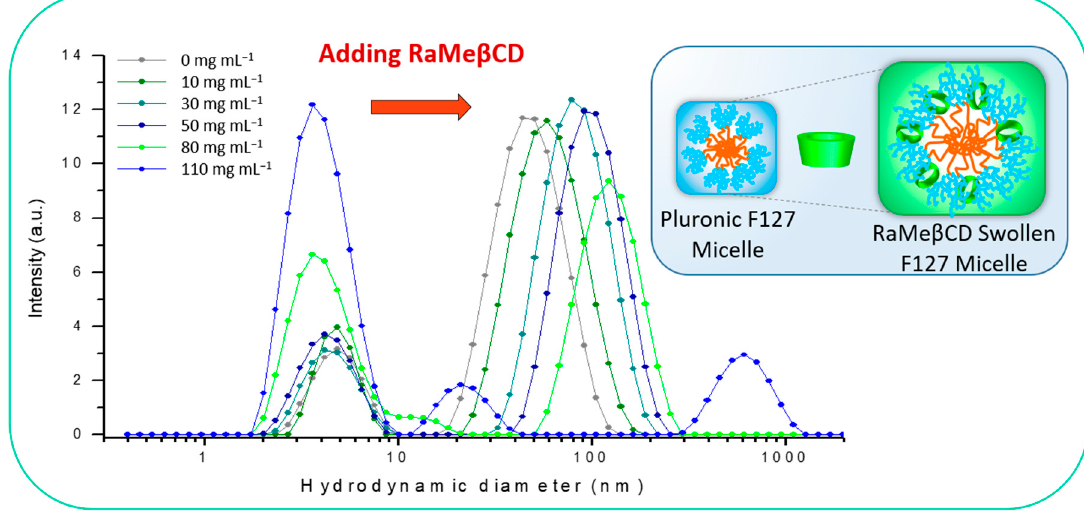
Figure 2. Dynamic light scattering (DLS) plots of the micellar solution of Pluronic F127 (10% w / v ) prepared with increasing concentrations of RaMe β CD from 10 mg mL − 1 to 110 mg mL − 1 .